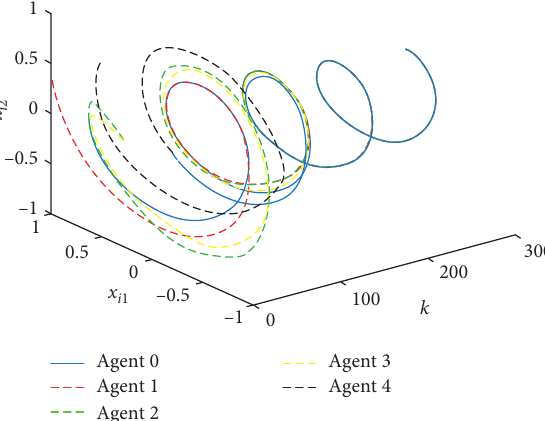
Figure 3: The tracking path for the system under the ET